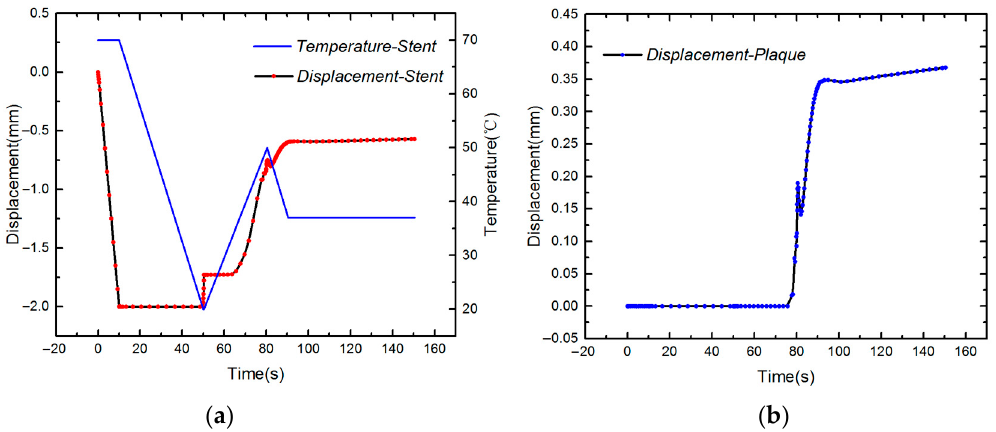
Figure 8. ( a ) Temperature and displacement of the SMP stent; ( b ) displacement of plaque.